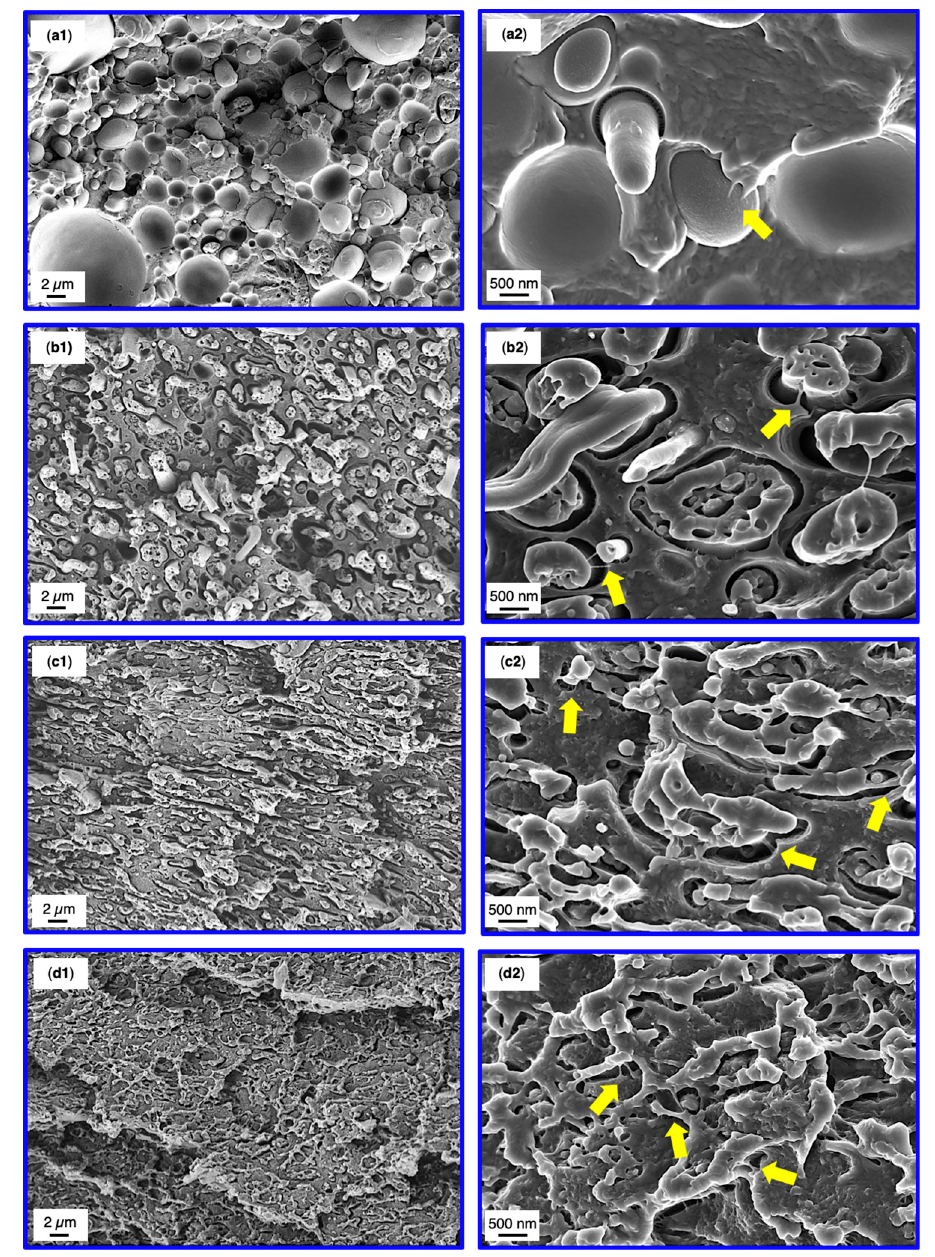
Figure 7. SEM micrographs subsequent to tensile testing of the 40 / 60 binary blend ( a1 ), 5 wt% SMA ( b1 ), 10 wt% SMA ( c1 ) and 15 wt% SMA (d1). Higher magnifications of the corresponding blends are depicted at the right column ( a2 , b2 , c2 , d2 ). Yellow arrows indicate matrix fibrillations.